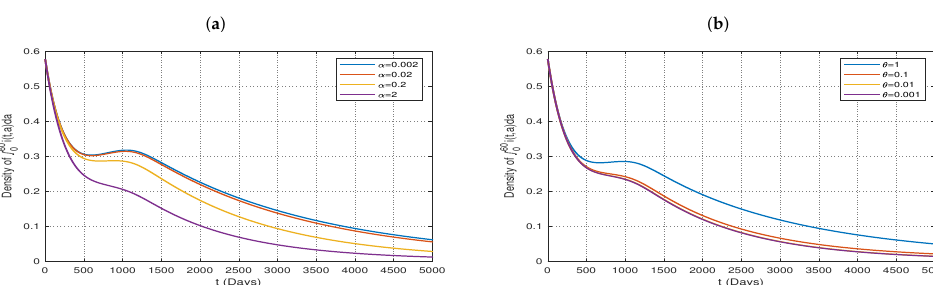
Figure 9. The influence of media coverage parameters α and θ on the cumulative distribution (cid:82) 60 i ( t , a ) d a of asymptomatic infected individuals: ( a ) the effect of α ; ( b ) the effect of θ . 0 Example 5. Sensitivity of the main parameters of model (4) on the basic production number R 0 .